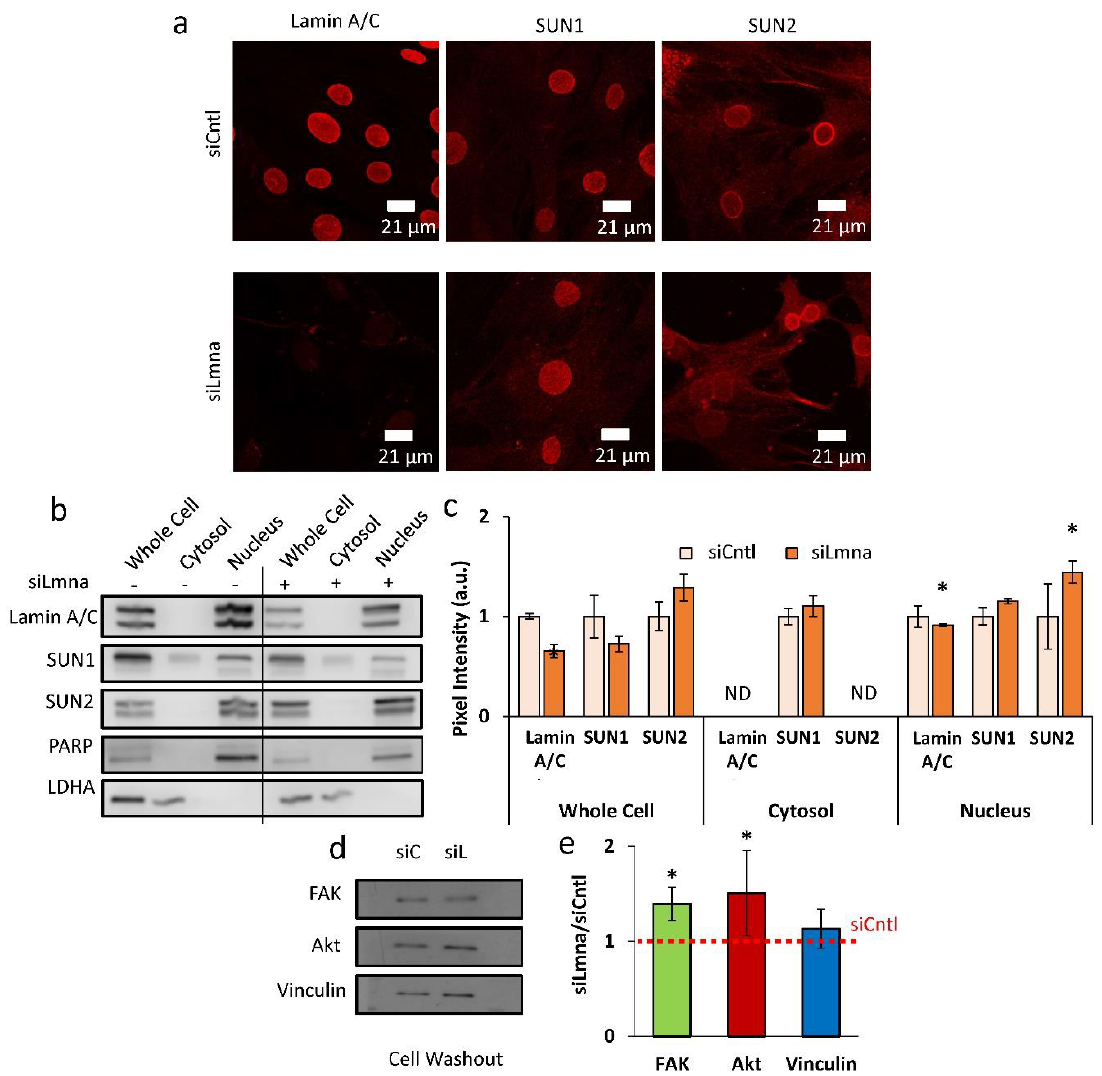
Figure 2. siRNA depletion of lamin A/C increases SUN2 nuclear levels and focal adhesion proteins: ( a ) Confocal images of cells treated with the siCntl and siLmna siRNA groups. Primary antibodies targeted lamin A/C, SUN1, and SUN2. Hoechst stained images can be found in Figure S2. ( b ) Representative western blots of cell fractionations (whole cell, cytosol and nucleus) with cells treated with either siCntl or siLmna. Primary antibodies targeted lamin A/C, SUN1, SUN2, PARP, and LDHA. Line represents removal of protein ladder marker lane, uncropped blots are provided in Figure S1. ( c ) Analysis of western of cell fractionation western blots ( n = 3/grp). siLmna treated cells had a 44% increase in nucleus fraction ( p < 0.05) compared to siCntl samples. SUN1 showed no detectable changes. ND represents non-detectable levels. ( d ) Representative western blot of focal adhesion proteins following a cell washout. Primary antibodies targeted of FAK, Akt, and Vinculin in siCntl and siLmna siRNA treated cells. ( e ) Densitometry analysis showed that, when compared to siCntl levels siLmna treated MSCs showed increased levels of total FAK (39%, p < 0.05) and total Akt (50%, p < 0.05), no change in Vinculin was detected ( n = 3/grp). Results are presented as mean ± STE. Scale bar: 21 µ m. Group comparisons were made via parametric two-tailed Student t -test (C) or one-way ANOVA followed by a Newman-Keuls post-hoc test. * p < 0.05 against control.